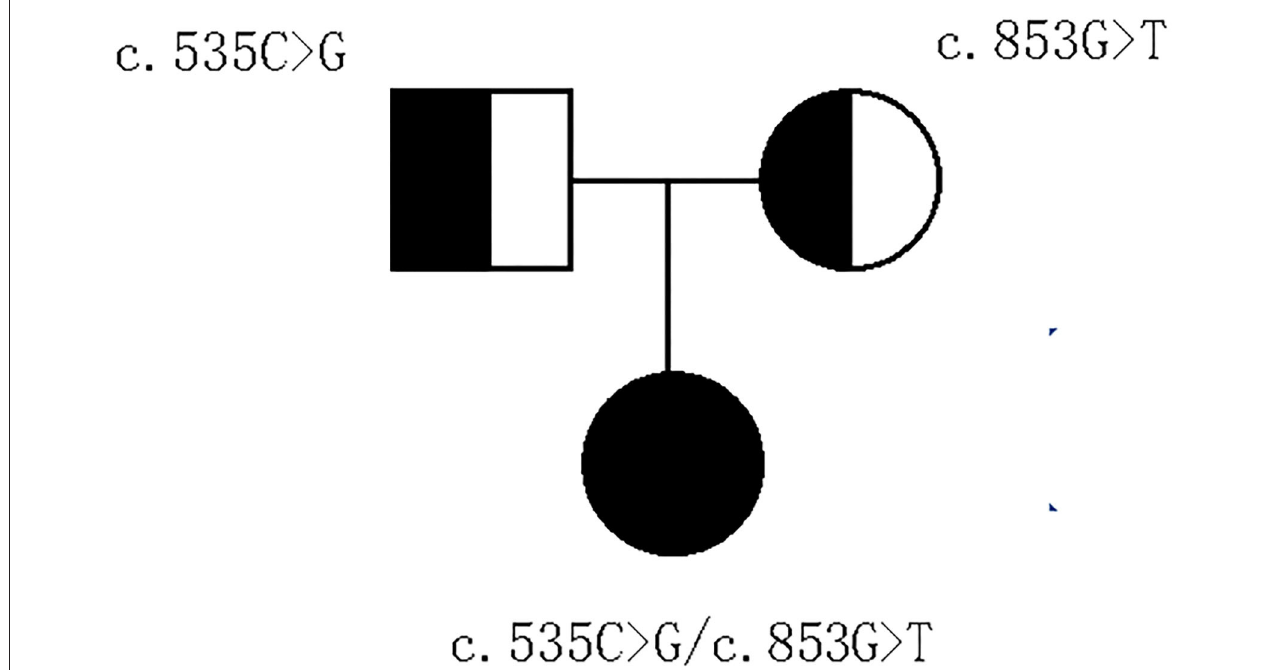
FIGURE 3 | Pedigree of the